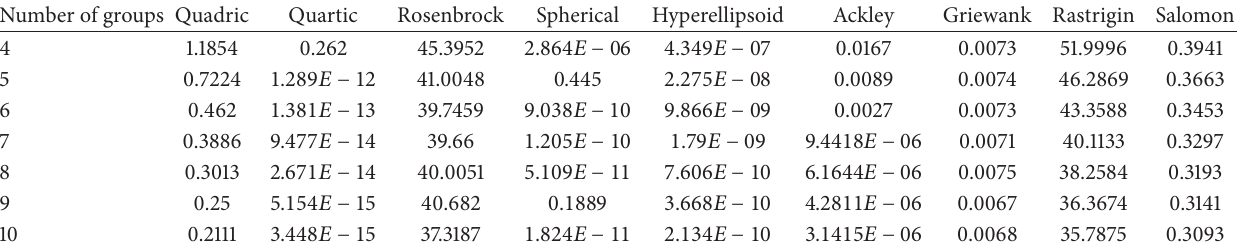
Table 9: Average results on the experiments involving the number of groups.